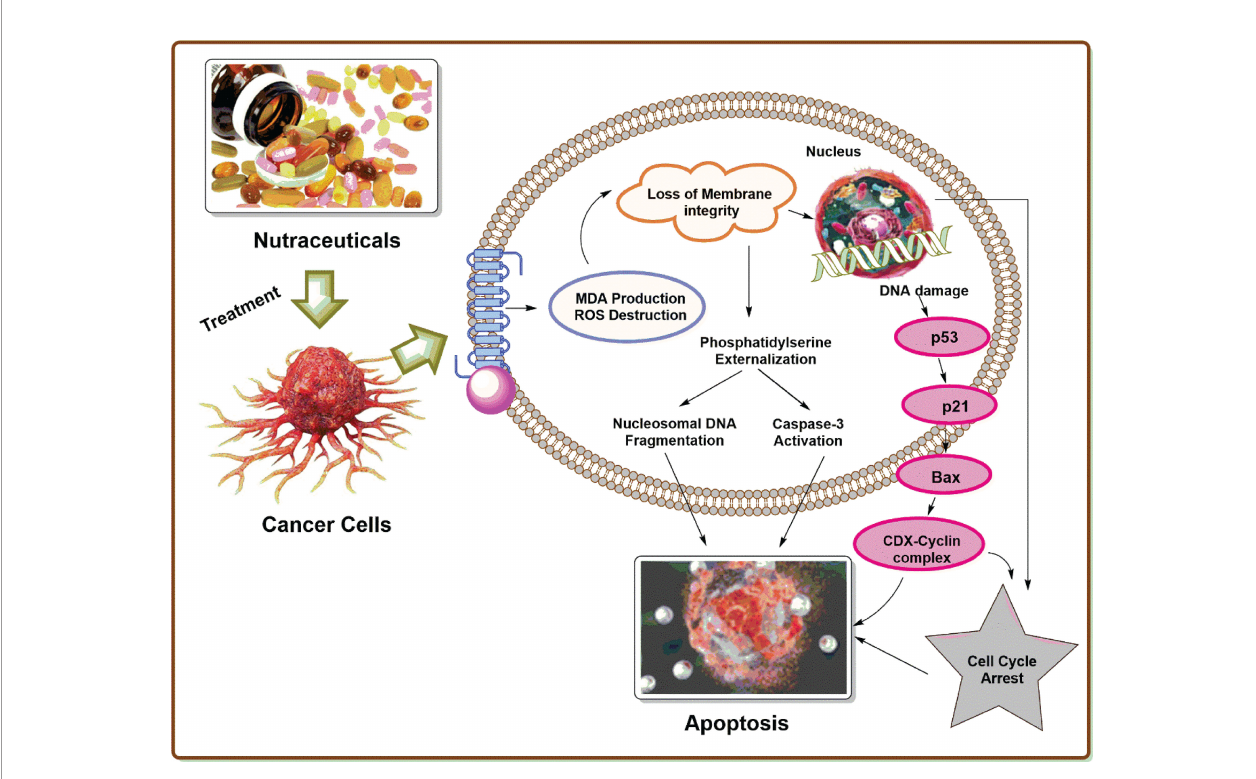
FIGURE 2 | Molecular targets and mechanism of action of nutraceutical products in prostate cancer